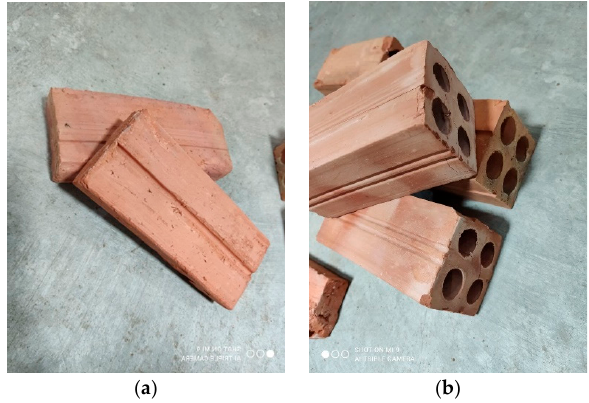
Figure 1. ( a ) Solid clay brick; ( b ) hollow clay brick.